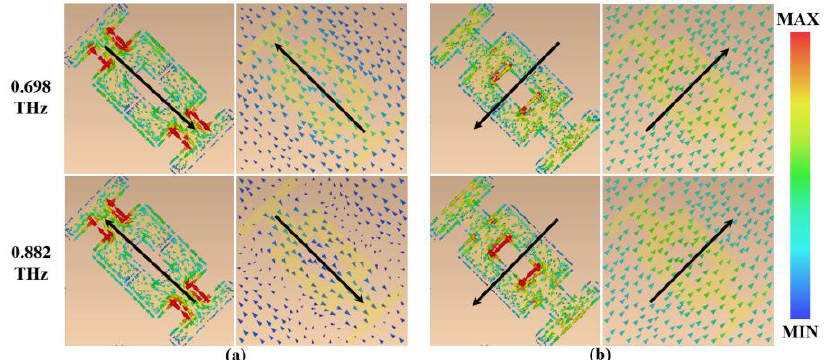
Figure 9. ( a ) Current distribution of the II-side metamaterials under v-polarization; ( b ) current dis- tribution of the II-side metamaterials under u-polarization.